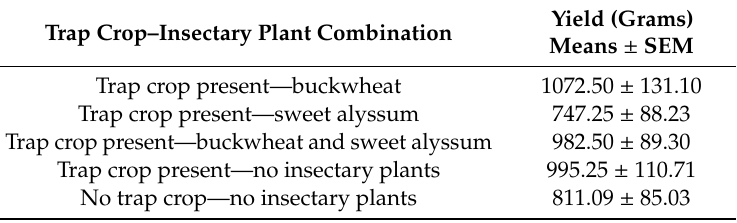
Table 2. Cabbage yield, expressed as mean weight of 18 cabbage heads sampled per plot, according to the trap crop / insectary plant treatment